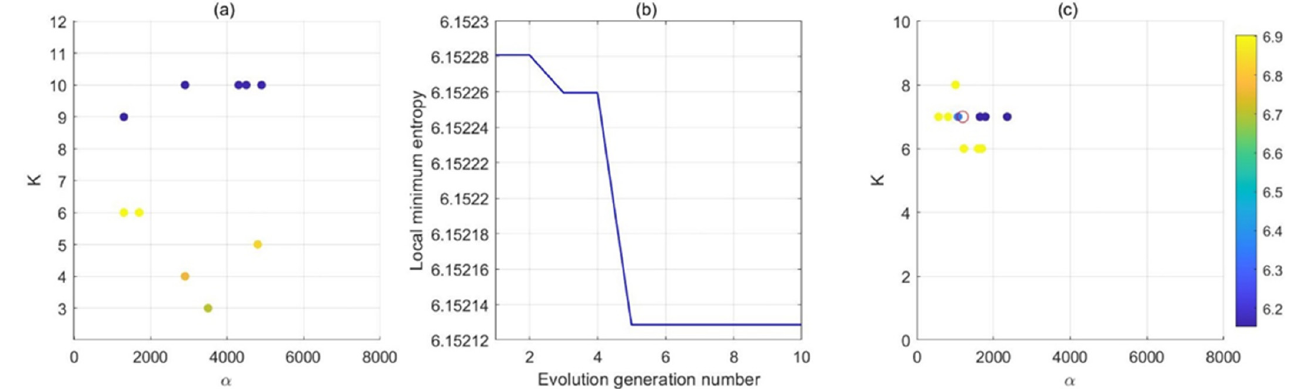
Figure 2. Determination of the optimal combination of [ K , α ] by PSO for the synthetic signal. ( a ) Initial position of the particles, ( b ) The change of local minimum entropy value with PSO evolution, and ( c ) the final position of the particles with the optimum value is marked in the red circle.